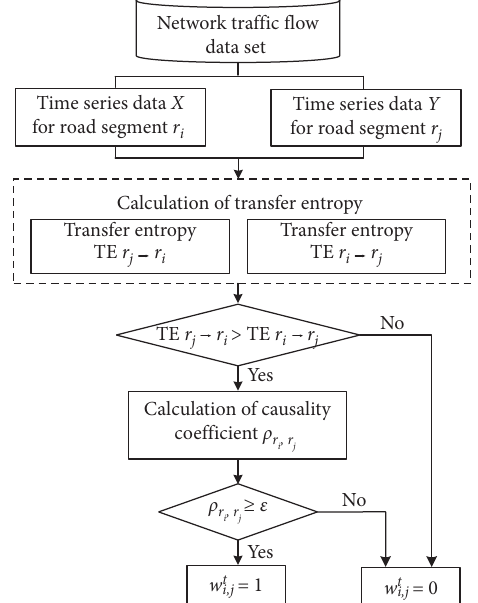
Figure 4: Calculation process for causality